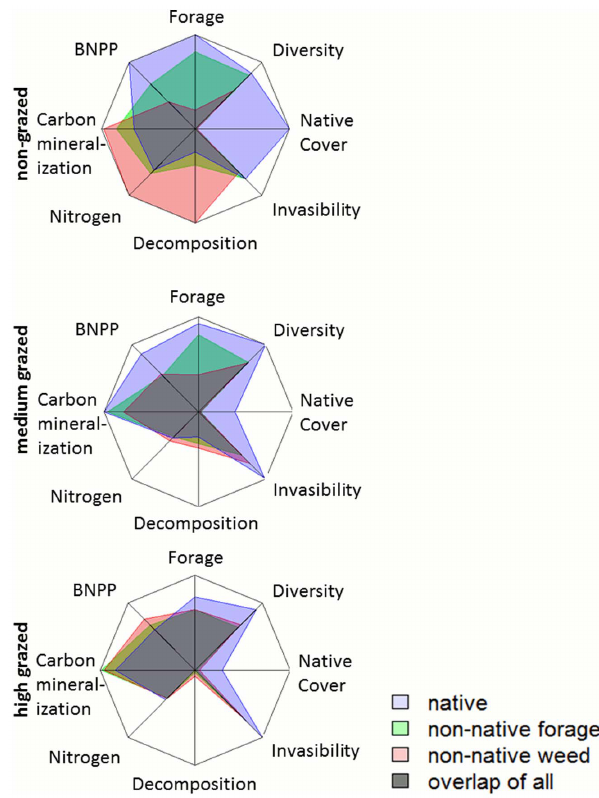
Figure 2. Ecosystem services provisioned by each species assemblage along a grazing gradient. Ecosystem services are scaled by maximum and minimum observed values (using back transformed least square means). The outside of the web corresponds to maximum service provisioning. Explanations of ecosystem services are given in Table